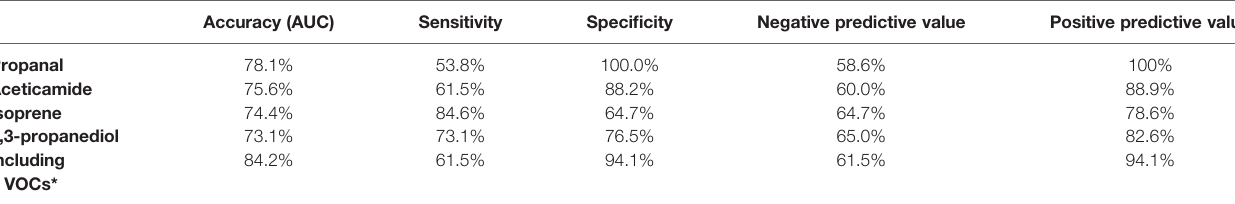
TABLE 2 | Accuracy, sensitivity and speci fi city for the Volatile organic compounds for the gastric cancer prediction model.